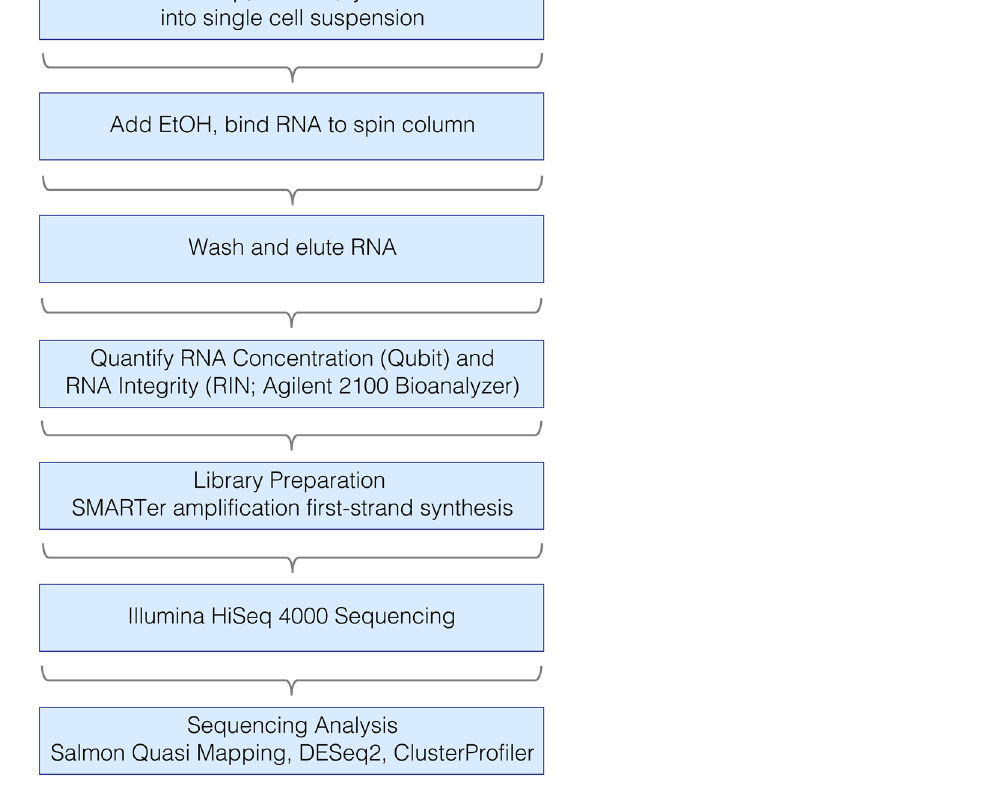
Figure 1. RNA Sequencing